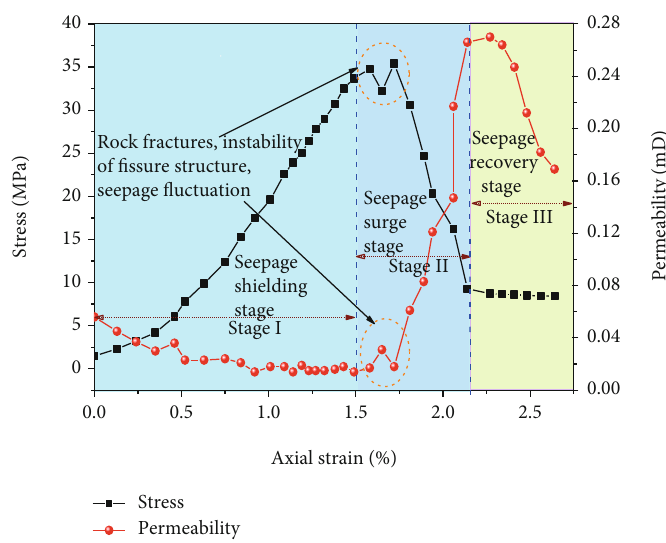
Figure 10: Coevolution curves of stress-strain and permeability in sandy mudstone triaxial tests.